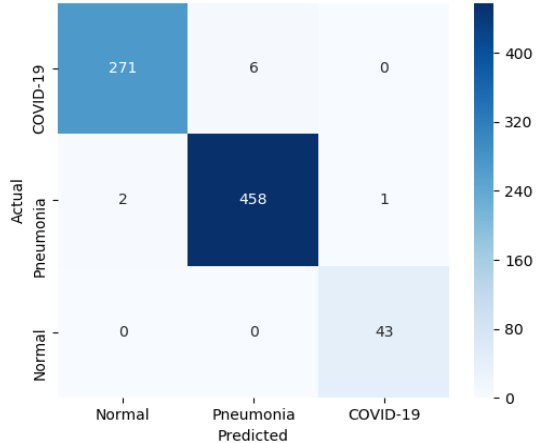
Figure 5. Matrix of the 3-class classification.